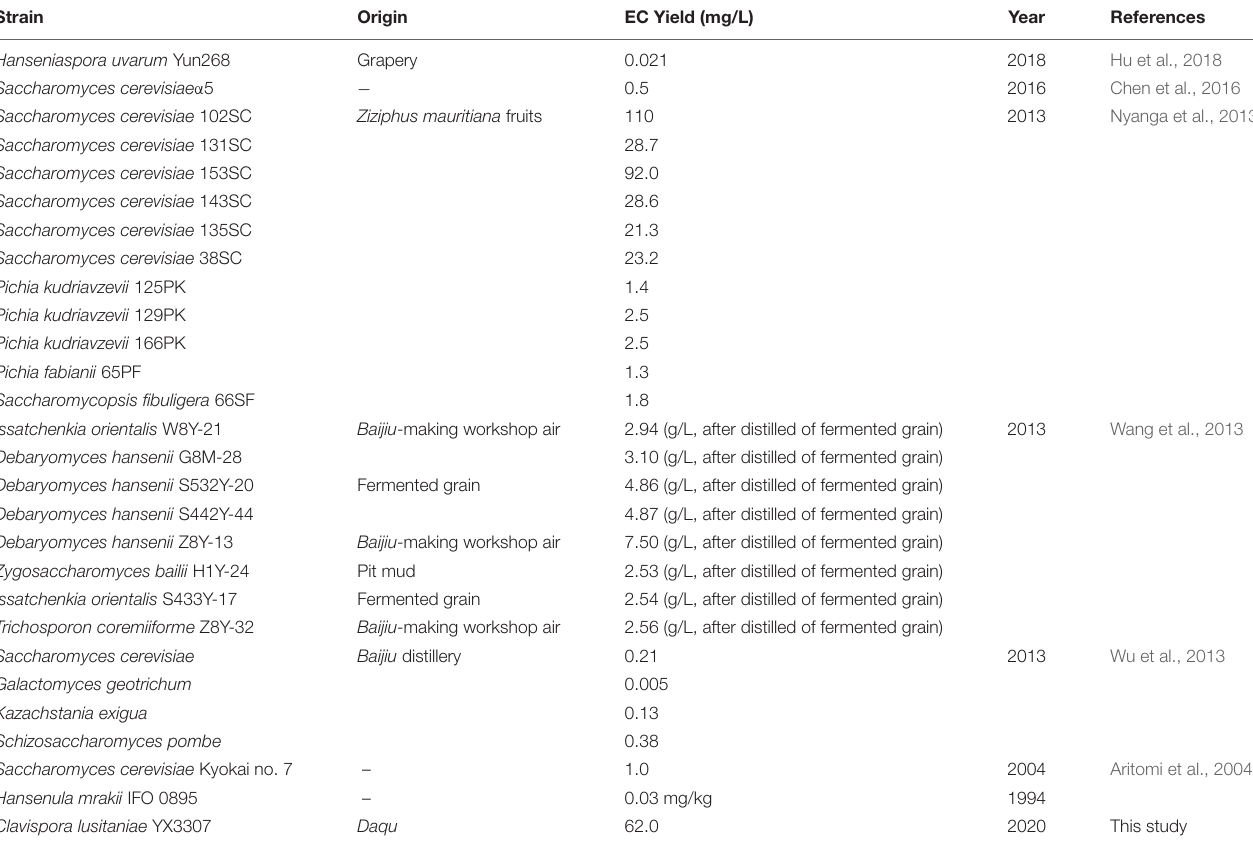
TABLE 2 | Summary of yeasts reported for EC yield.